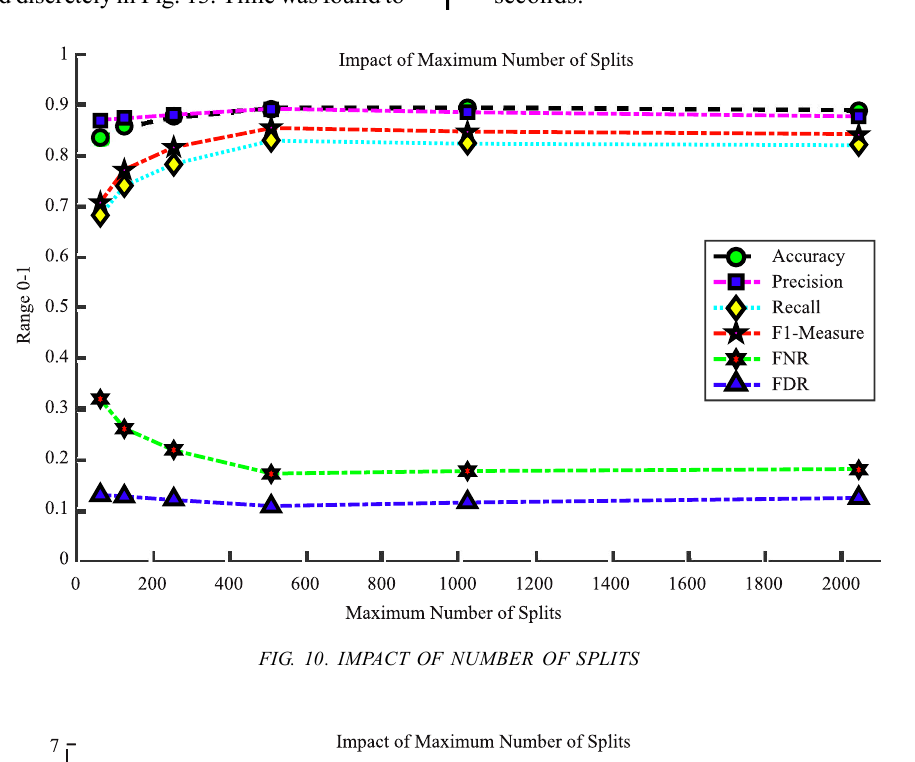
FIG. 10. IMPACT OF NUMBER OF SPLITS